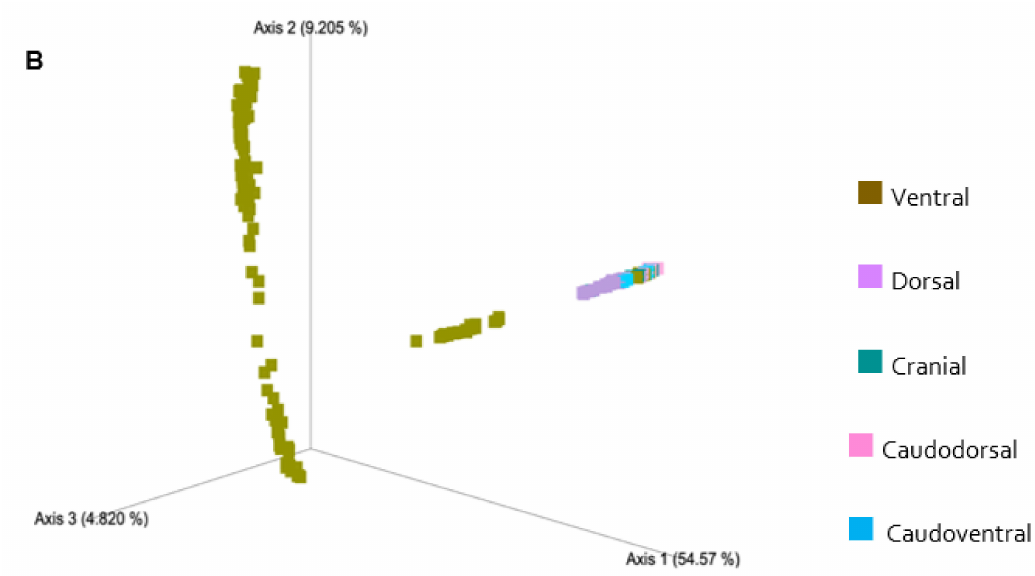
Figure 5. Principal-coordinate analysis of Bray-Curtis dissimilarities classified by study ( A ) and ( B ) biopsy location. The amount of variation explained by the principal coordinates is given in the axes (%). In ( A ), clustering seems to occur based on the hypervariable region used in the study.